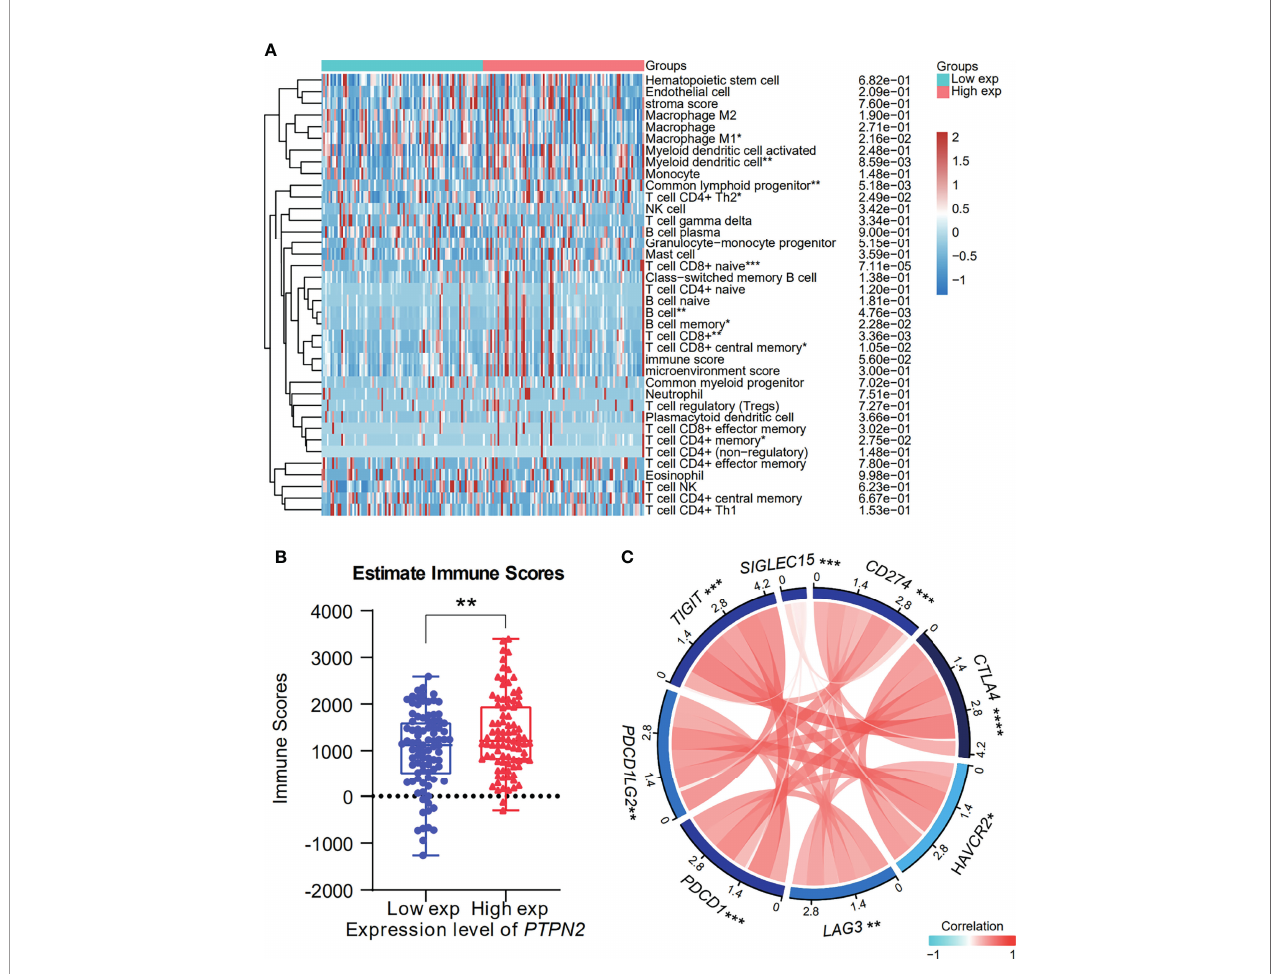
FIGURE 12 | Correlation analysis of PTPN2 expression with TIICs and Immune Score in pancreatic adenocarcinoma. (A) Immune cells score heatmap associated with PTPN2 expression. (B) Comparison of PTPN2 expression between the high and low immune score groups of PAAD. (C) Correlation analysis of PTPN2 expression levels with 8 immune checkpoint gene levels in PAAD. *p < 0.05, **p < 0.01, ***p < 0.001, ****p <